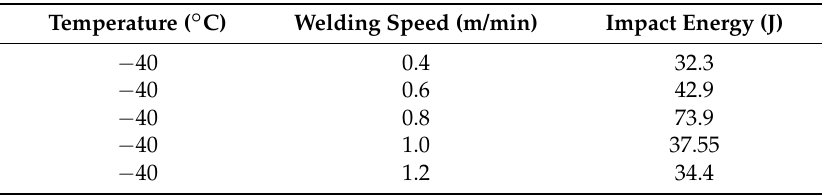
Table 4. The results of impact